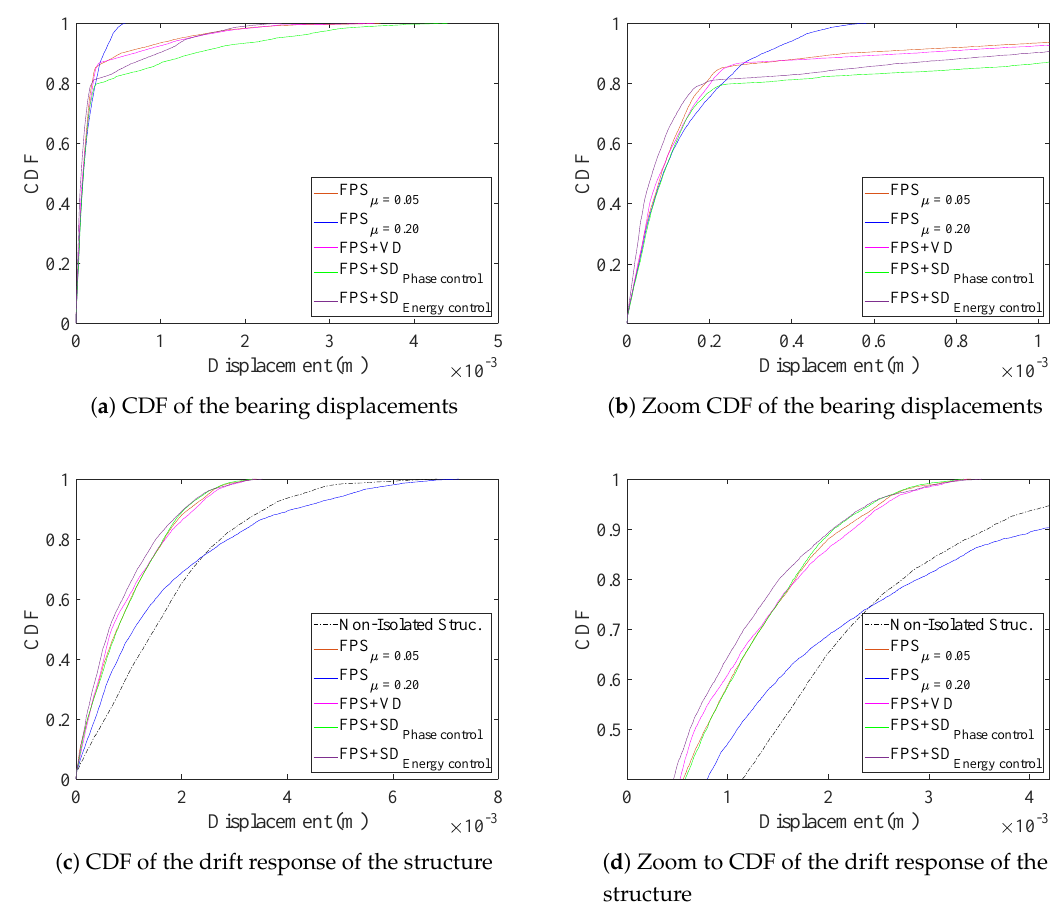
Figure 14. CDF of bearing plate displacement and drift under the serviceability